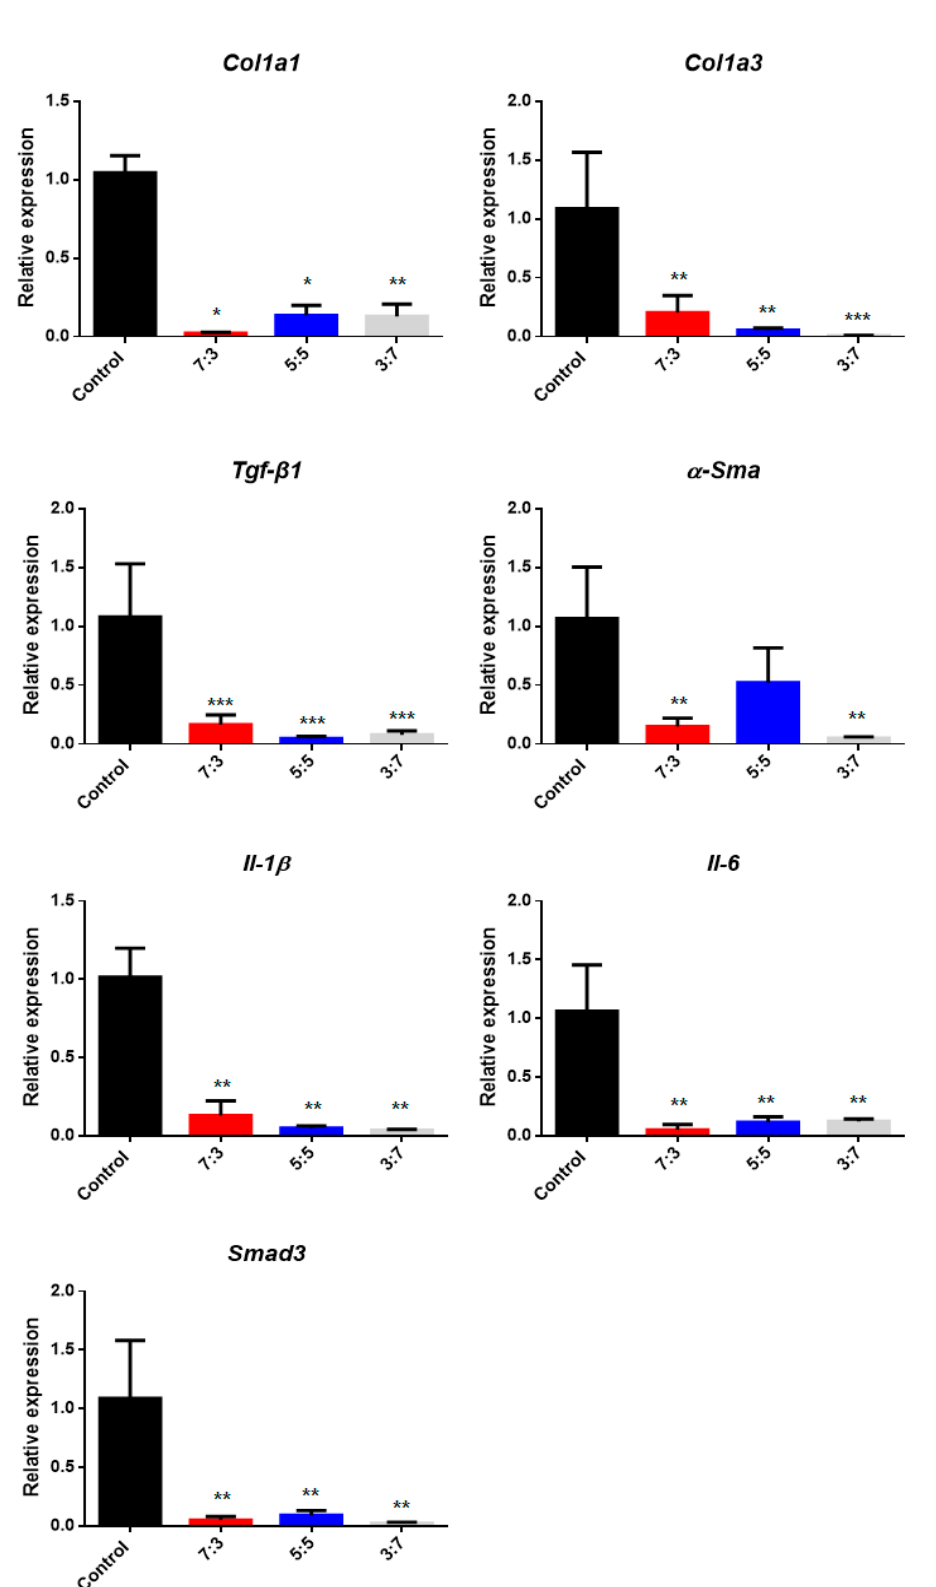
Figure 12. Relative expression of genes in tissue for hydrogel-coated poly(dimethylsiloxane) PDMS (CHO–HA/Gel–NH 2 = 7:3, 5:5, and 3:7) compared to the control group (bare PDMS). (* p < 0.05, ** p < 0.01, *** p < 0.001, Mann–Whitney test, compared to bare PDMS).